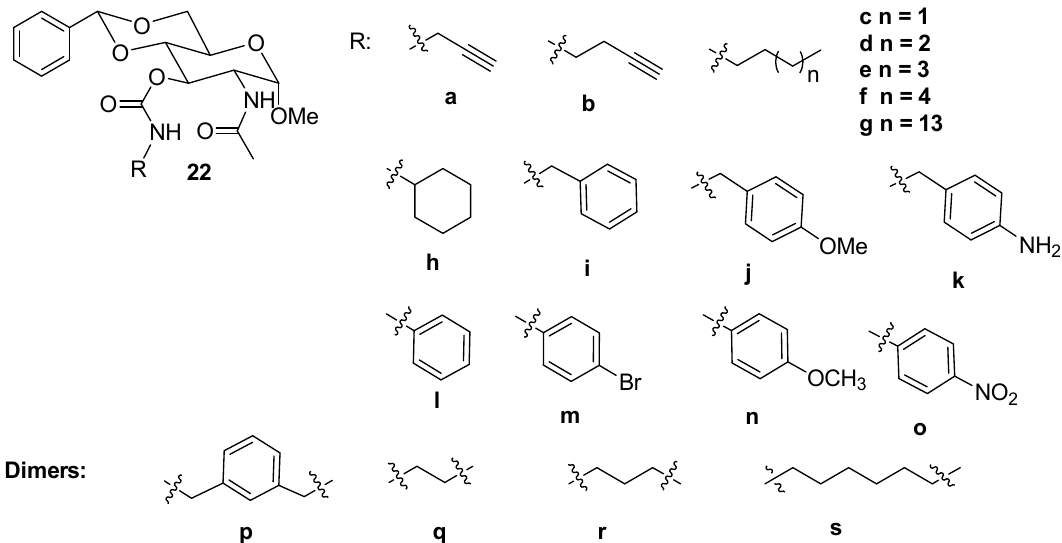
Figure 15. Structures of C-3 carbamates [54], n stands for the number of repeating CH 2 .